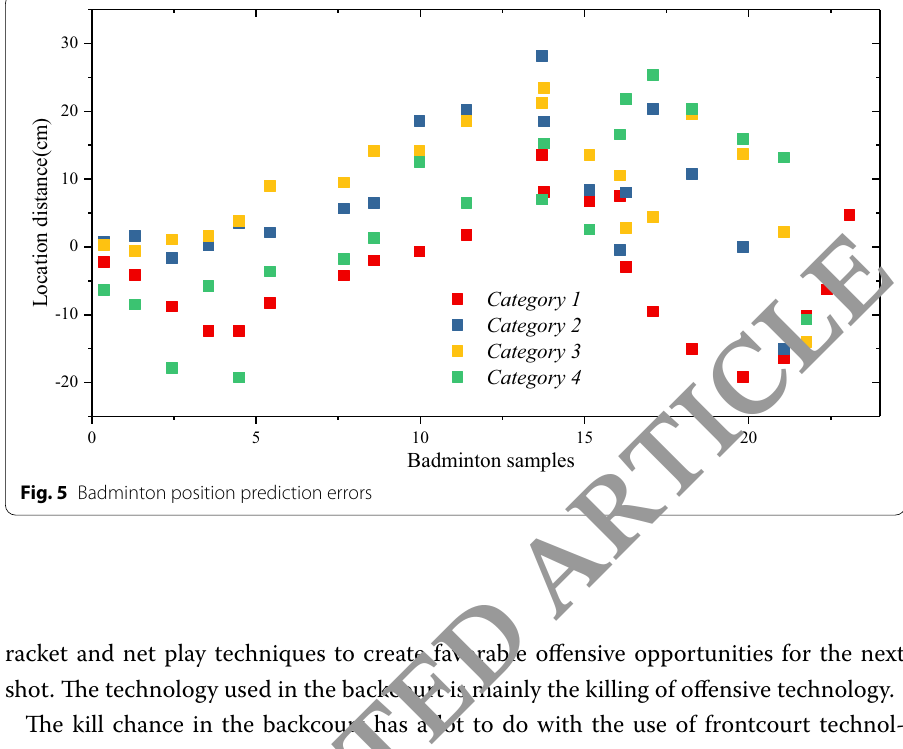
Fig. 5 Badminton position prediction